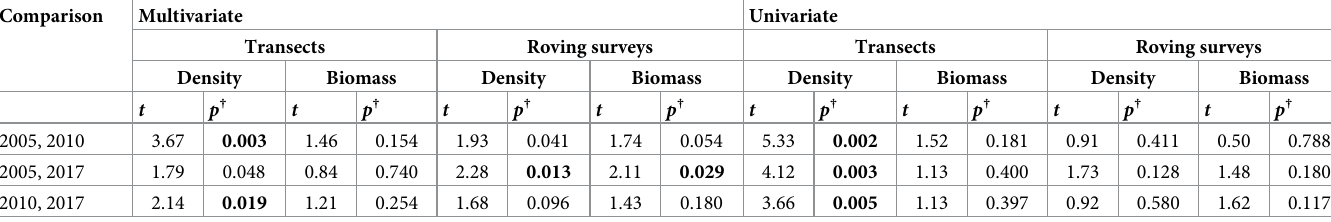
Table 2. Results of A posteriori pairwise comparisons from the MNTZ. Comparison